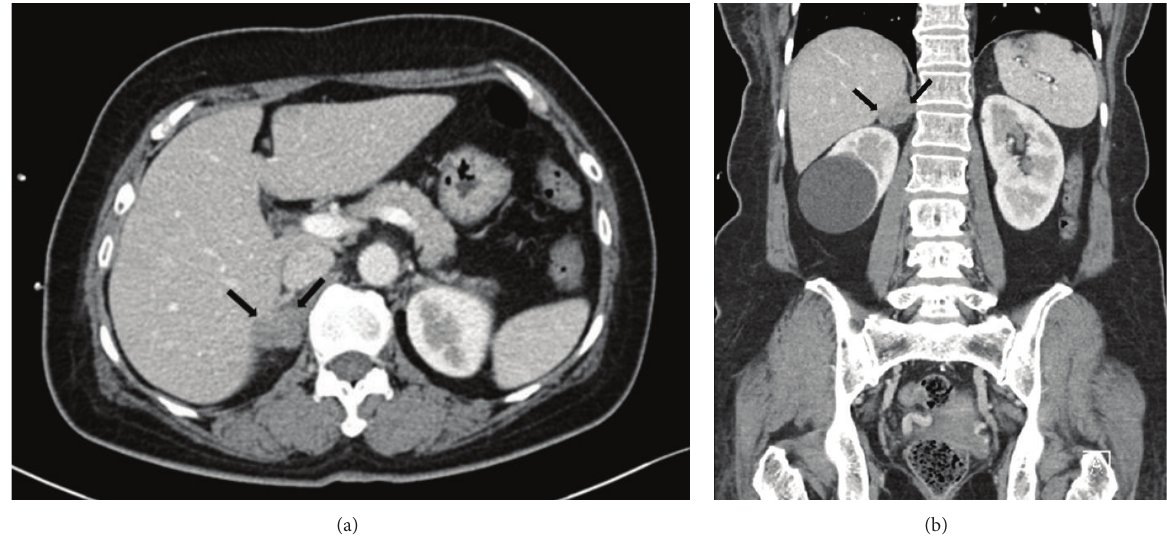
Figure4:Axial(a)andcoronal(b)abdominalcomputedtomographyimagesduringthelatearterialphaseshowa1.5cmmasswithalobulated contour and mild enhancement in the right adrenal gland (black